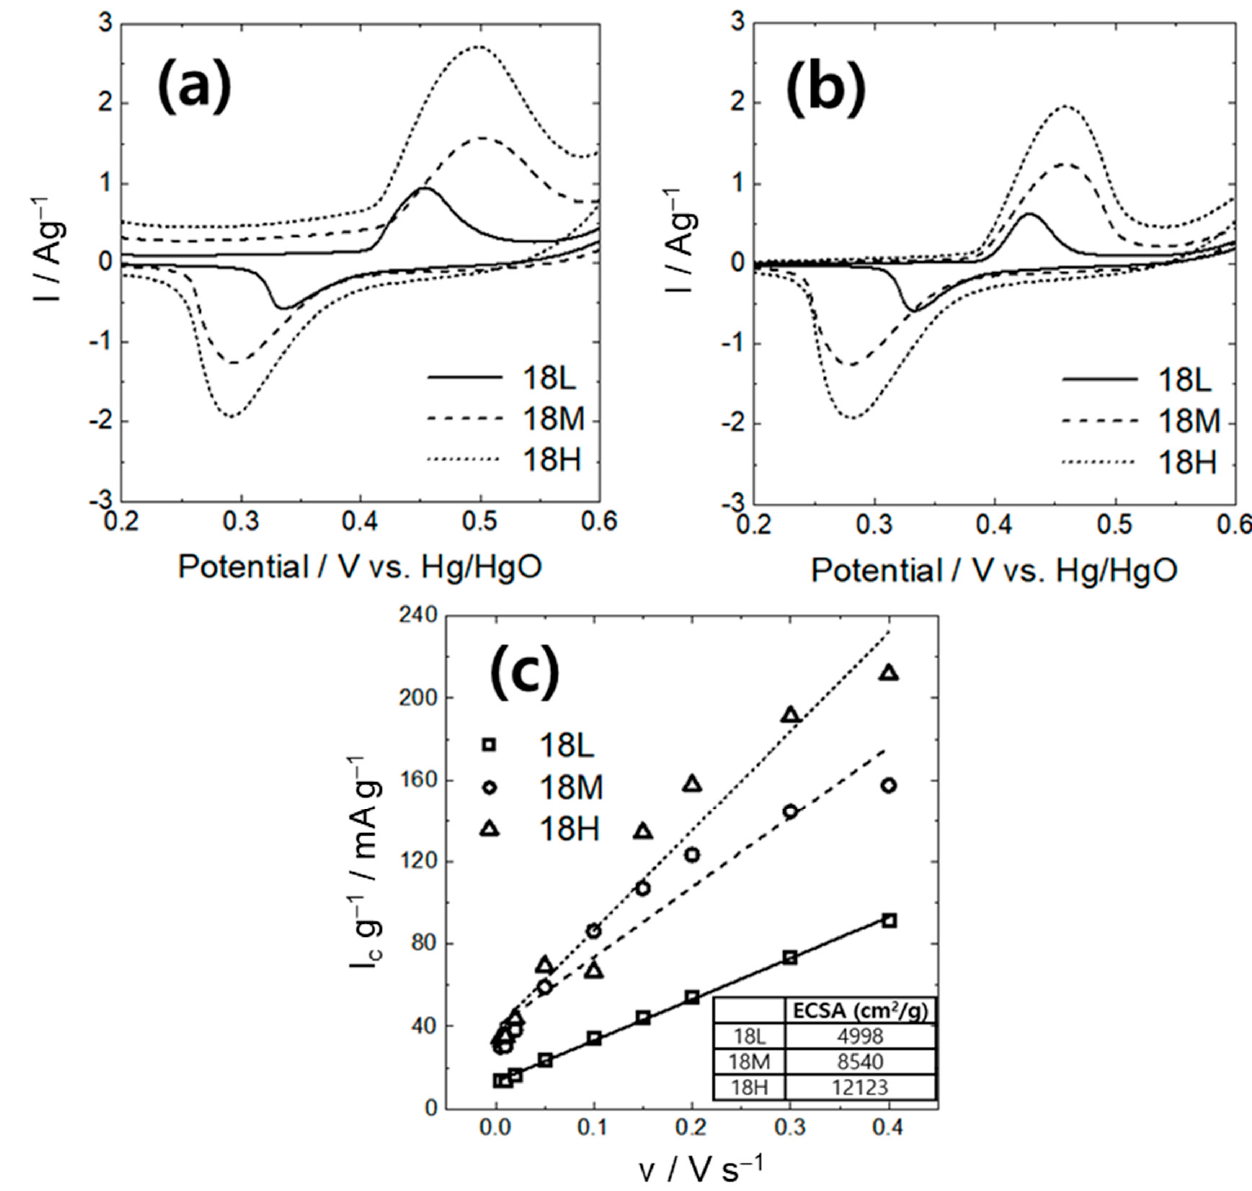
Figure 5. ( a ) The first and ( b ) the second cyclic voltammograms and ( c ) a charging current vs. scan rate plot (inset table is the estimated ECSA values), obtained from the nickel phosphide nanowires prepared at different combinations of pH and reducing agent content (Samples 18L, 18M, and 18H).